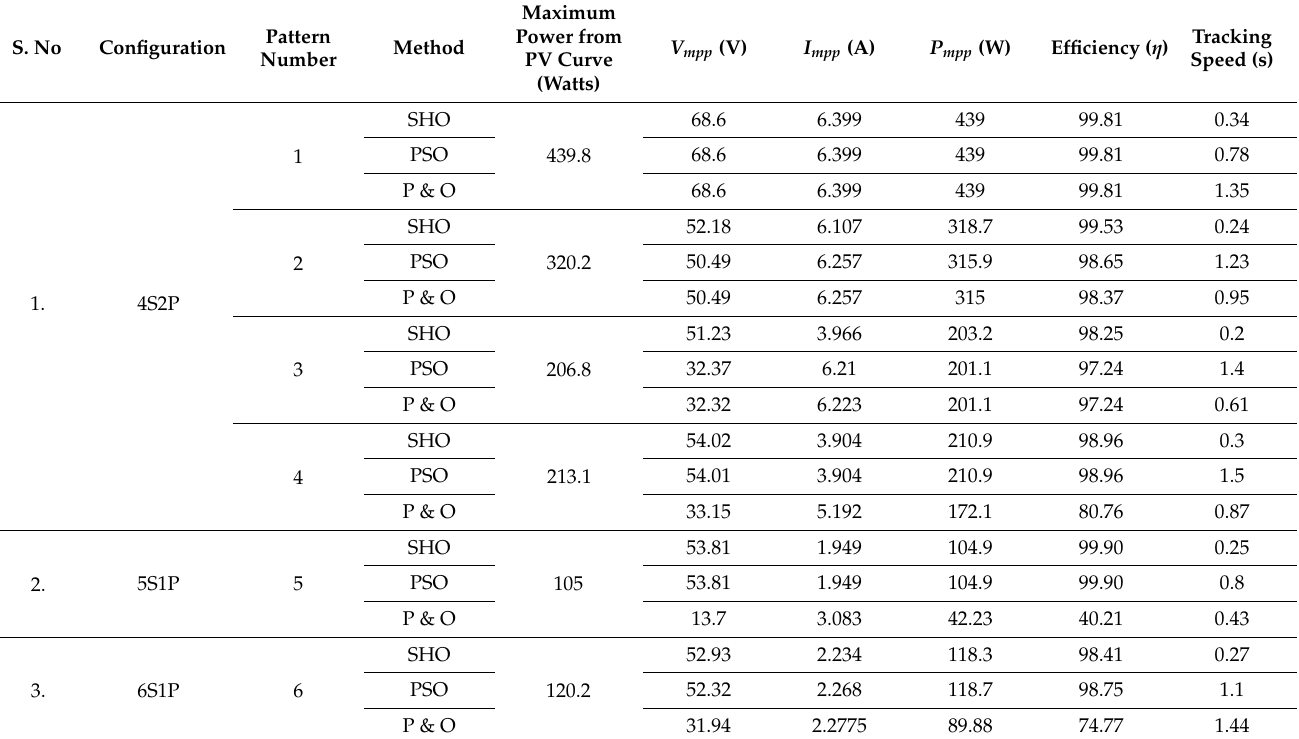
Table 4. Comparative results of SHO, nested PSO, and FA-PSO algorithms for three peaks.